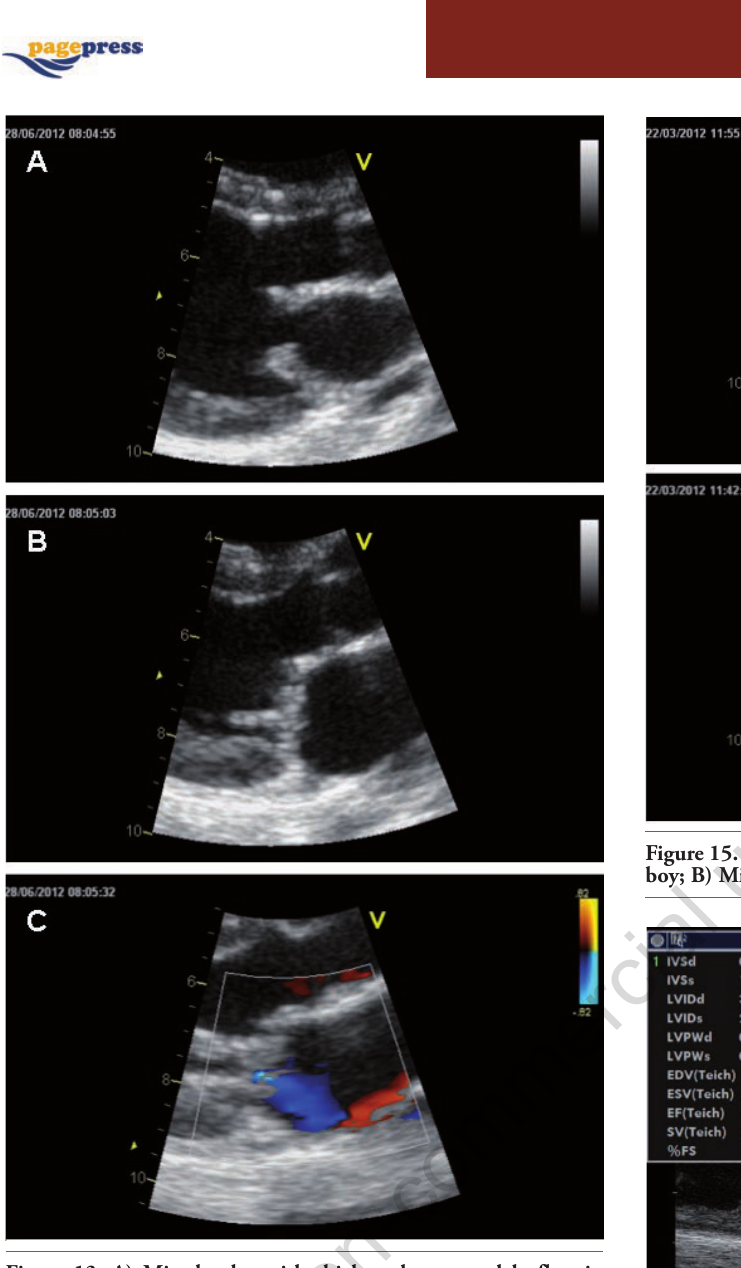
mm).Figure 13. A) Mitral valve with thickened, retracted leaflets in mucopolysaccharidosis type II; B) Mitral valve defect of apposi- tion and coaptation; C) Mitral regurgitation.